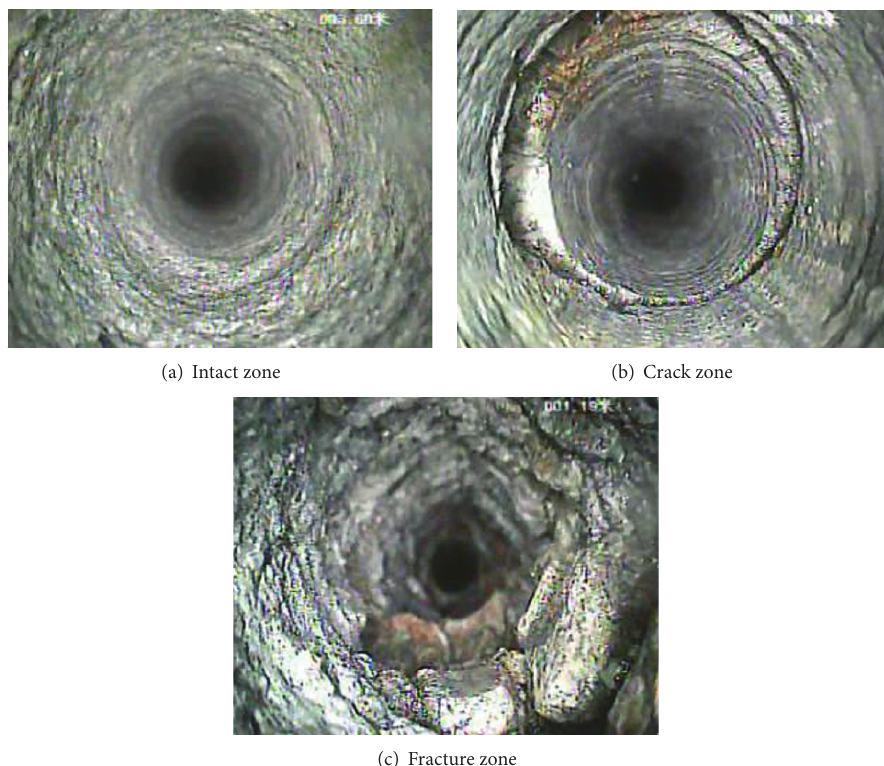
Figure 9: Three typical zones around the surrounding